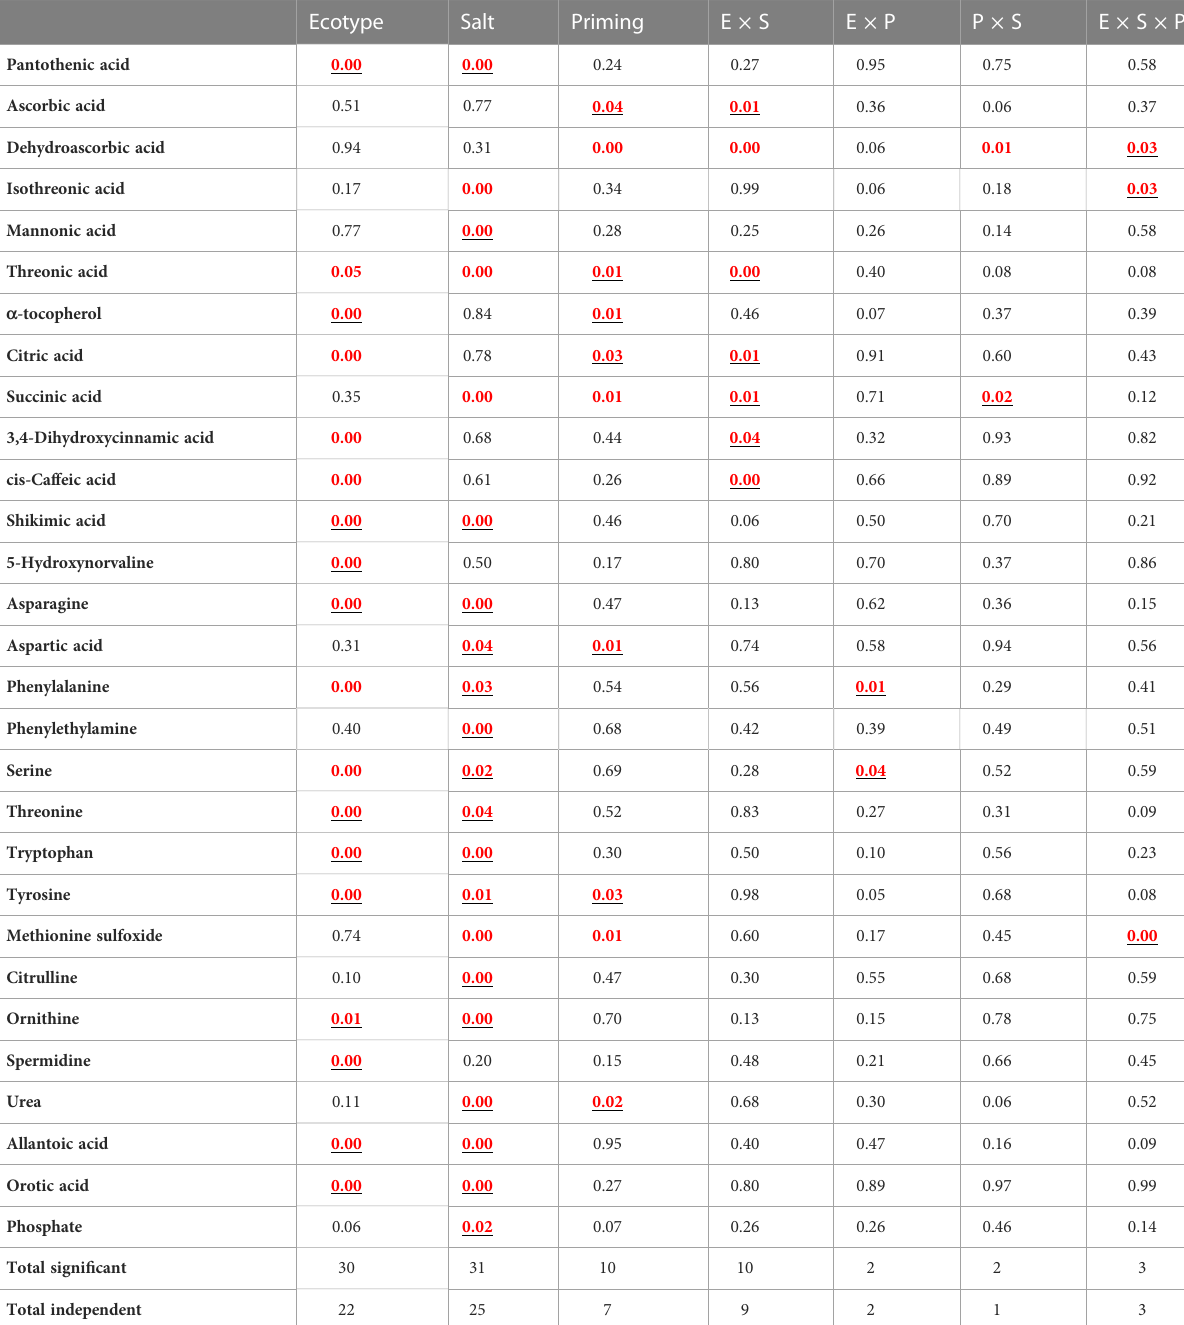
Total independent Signi fi cant p-values are in bold and red. The underline shows the signi fi cant independent effect that is not included in a signi fi cant interaction and the more complex interaction that includes theeffect ofindependent factors ormoresimpleinteractions (the posterior interpretation isonly based onthe complexinteractions that nestthe simpleeffect andthe independent effect that are not included in an